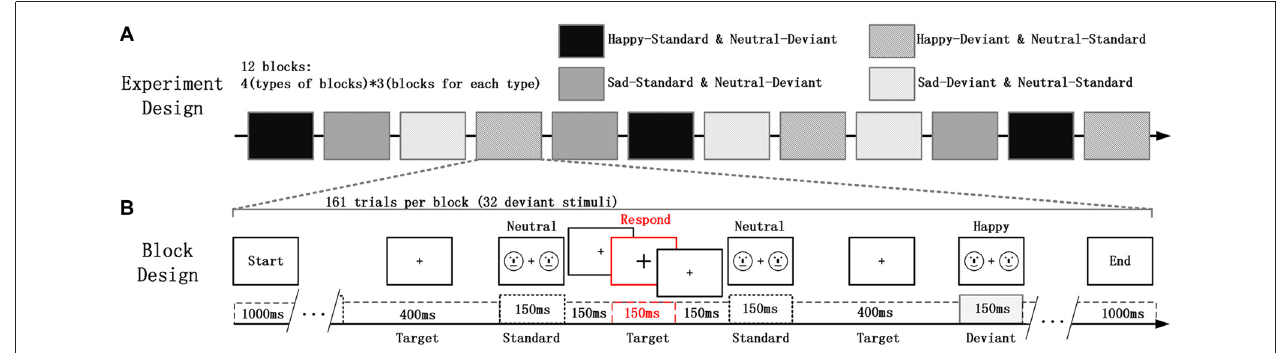
FIGURE 1 | (A) The experiment consisted of four types of blocks and a total of 12 experimental blocks (each type of block consisted of three blocks). (B) Each block contained 161 trials of two kinds of schematic faces. Two schematic faces displaying the same expression were presented peripherally in each screen for 150 ms. This screen was followed by an inter-stimulus interval of 450 ms, during which the size of the fixation cross was changed occasionally. The participants’ task involved a quick button-press when the cross became larger.